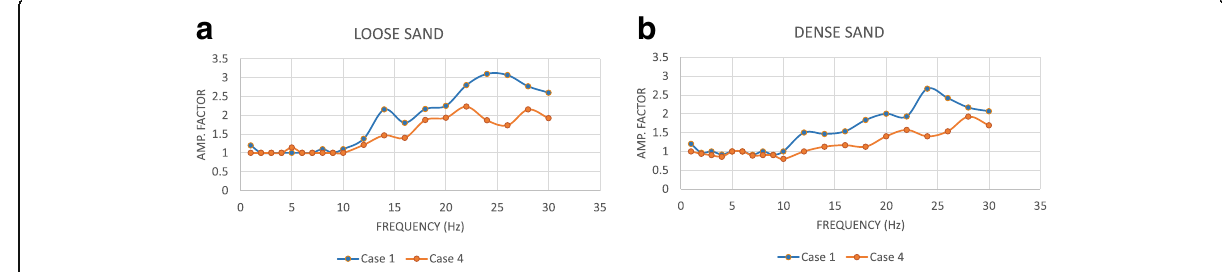
Fig. 6 Amplification factor. a In the loose sand condition; b In the dense sand